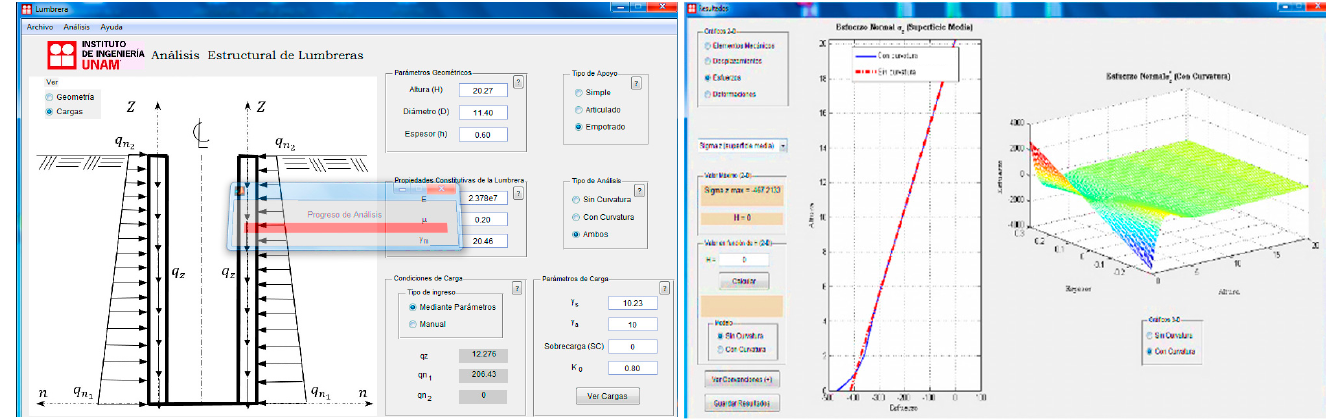
Figure 5. Program analysis and viewer results.